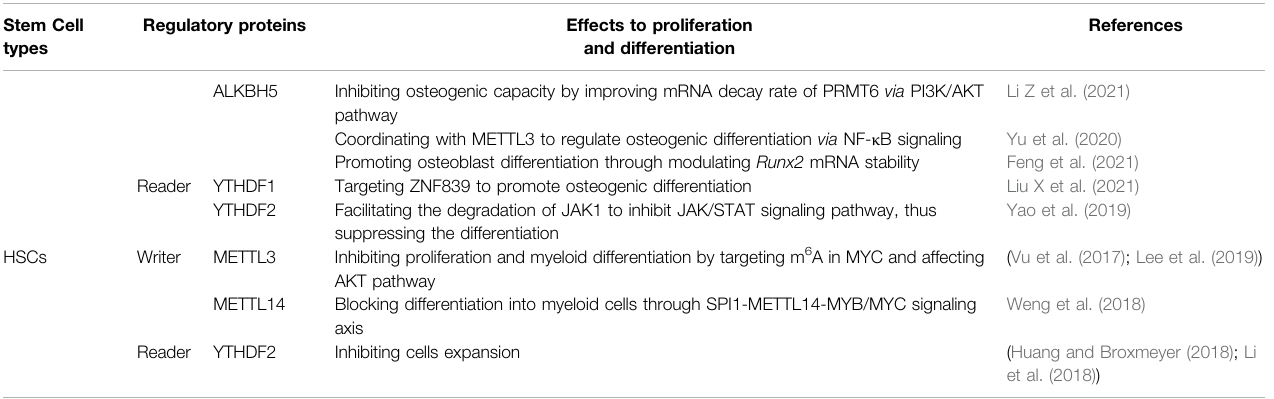
TABLE 1 | ( Continued ) RNA methylation regulators and their functions in different types of stem